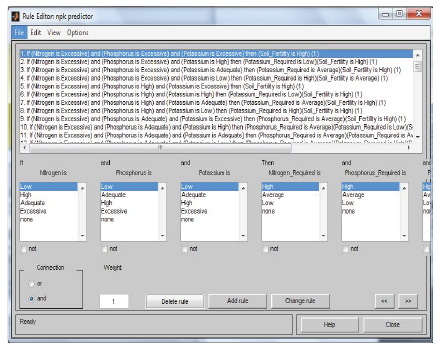
Figure 2: Rule editor.